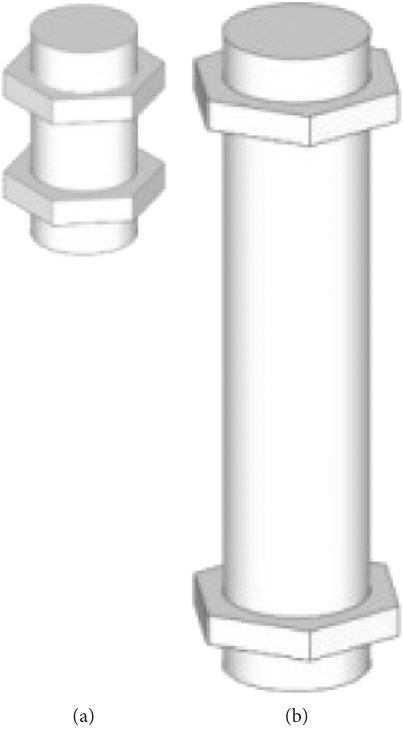
Figure 12: Screw and tightening nuts. (a) Short screw: 8mm in diameter and 20mm length; (b) long screw: 8mm in diameter and 50mm length.